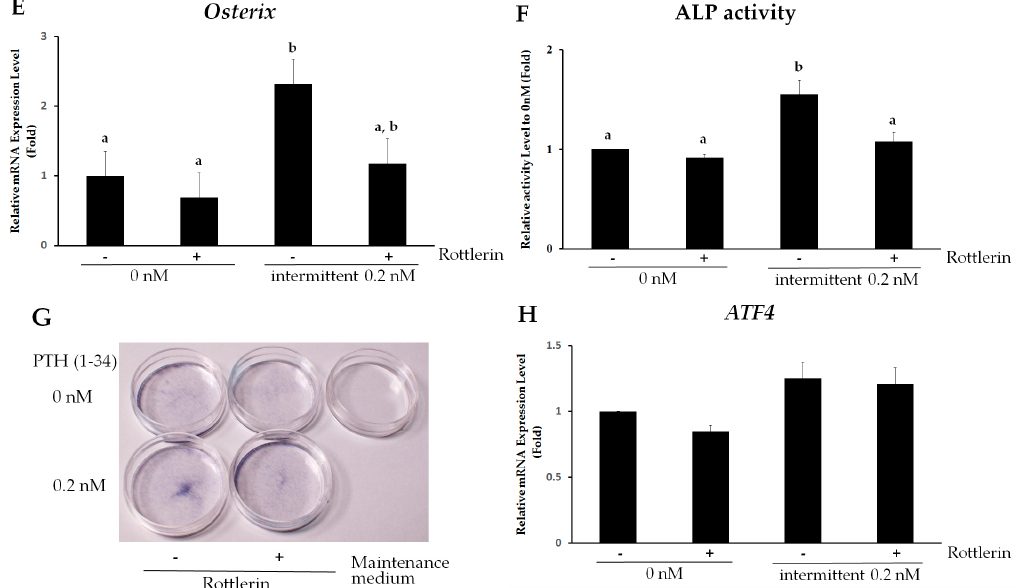
Figure 5. PKC δ mediates intermittent parathyroid hormone (PTH) (1–34)-enhanced osteogenesis in human mesenchymal stem cells (hMSCs). ( A – E ) Relative quantitative gene expression of ( A ) PKC δ ; ( B ) RUNX2 ; ( C ) COL1a1 ; ( D ) ALP and ( E ) Osterix in hMSCs on day 7 of osteogenic differentiation after intermittent treatment with or without 0.2 nM of PTH (1–34) in the presence or absence of the specific PKC δ inhibitor Rottlerin. Data are presented as mean ± SD ( n = 3). Different letters represent significant differences between groups ( p < 0.05). ( F , G ) Functional assay for osteogenic differentiation after intermittent treatment with or without 0.2 nM of PTH (1–34) in the presence or absence of Rottlerin using hMSCs on day 7 of osteogenic induction. ( F ) Relative alkaline phosphatase (ALP) activity of the sample is reported as the ratio of ALP activity to the corresponding protein concentration (units/mg). Data are represented as mean ± SD ( n = 3). Statistical data analysis was performed by performing one-way ANOVA with Tukey’s post-hoc tests. Different letters represent significant differences between groups; those with the same letters were not significant ( p < 0.05); ( G ) ALP staining in hMSCs on day 7 of osteogenic induction and after intermittent treatment with 0.2 nM PTH (1–34) and Rottlerin; ( H ) Relative quantitative gene expression of ATF4 in hMSCs on day 7 of osteogenic differentiation after intermittent treatment with or without 0.2 nM of PTH (1–34) in the presence or absence of the specific PKC δ inhibitor Rottlerin.